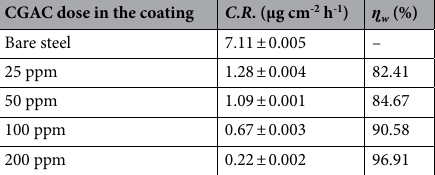
CGAC dose in the coating C.R . (µg cm -2 h -1 ) ɳ w (%)